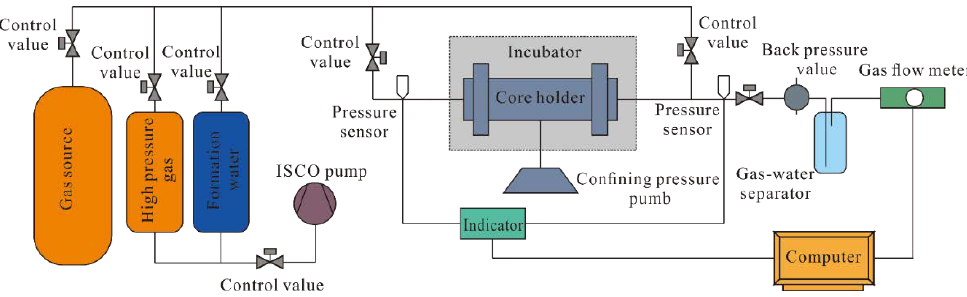
Figure 2. The experimental flow chart of the single-core experiment.